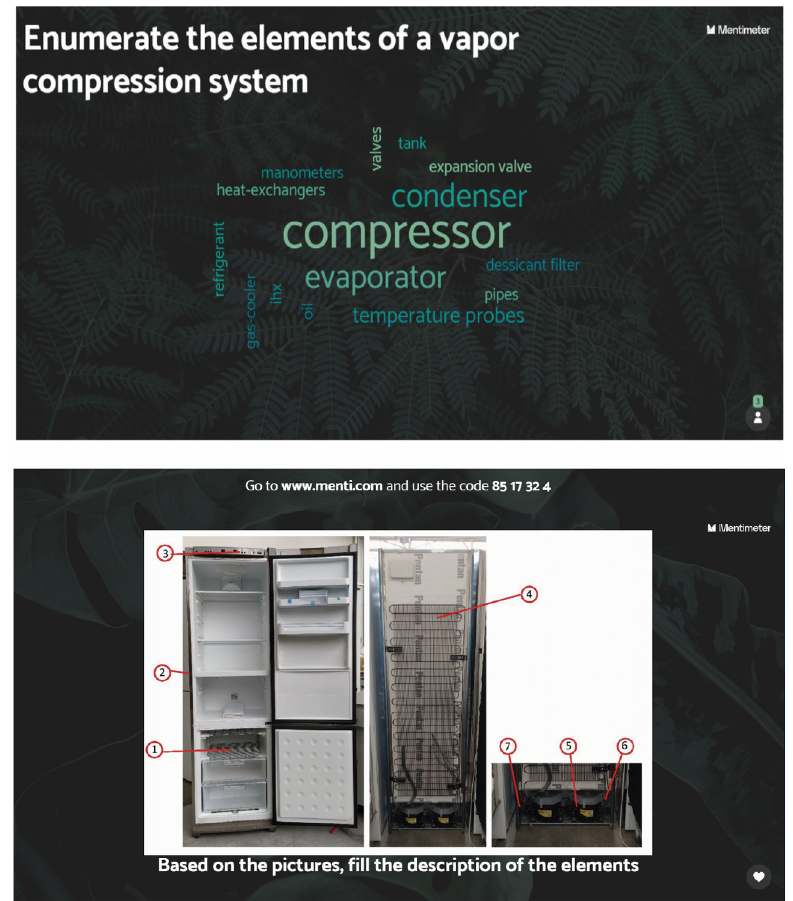
Figure 2. Two parts of the test developed by the